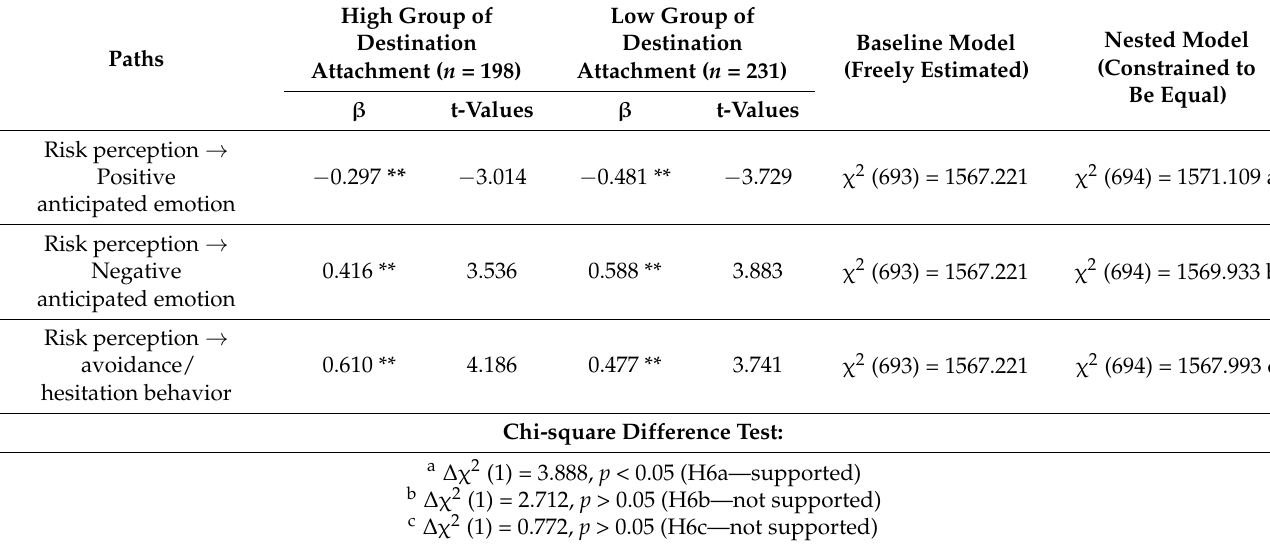
Table 3. Baseline and invariance model assessment